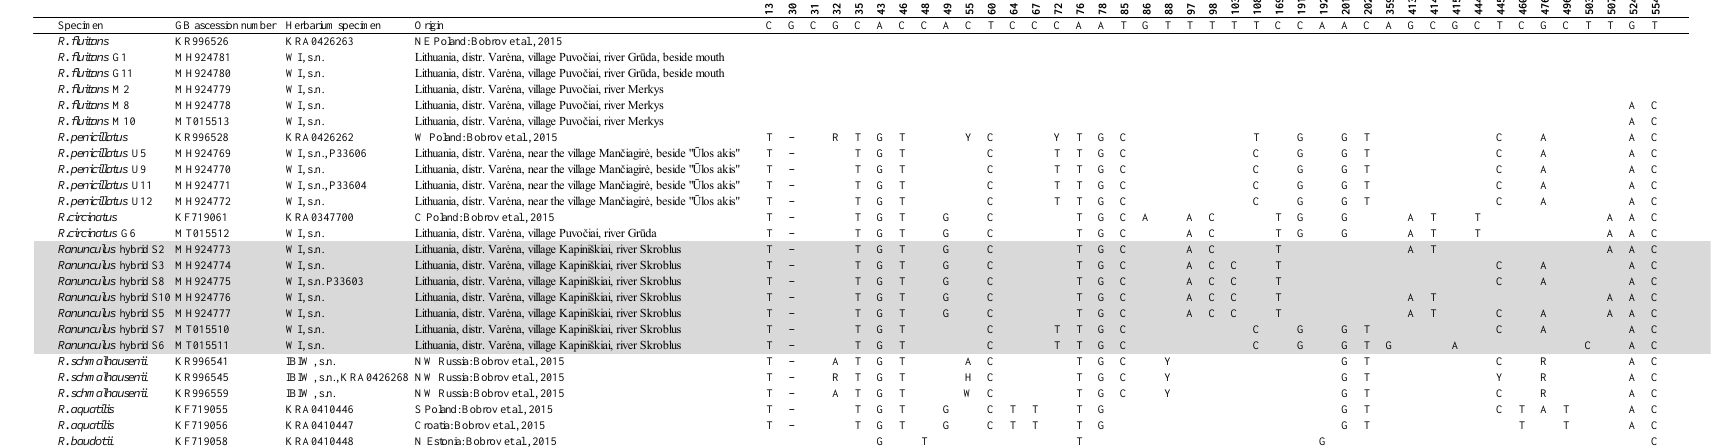
Table 3. Sequence variation in the internal transcribed spacer (ITS) region of Ranunculus sect. Batrachium (14 sequences from populations Gruda, Skroblus (marked by grey color), and Ula and 12 sequences from the GenBank ® database). G—Gruda River (homophyllous plants); S—Skroblus River (heterophyllous plants); U—Ula River (homophyllous and heterophyllous plants).